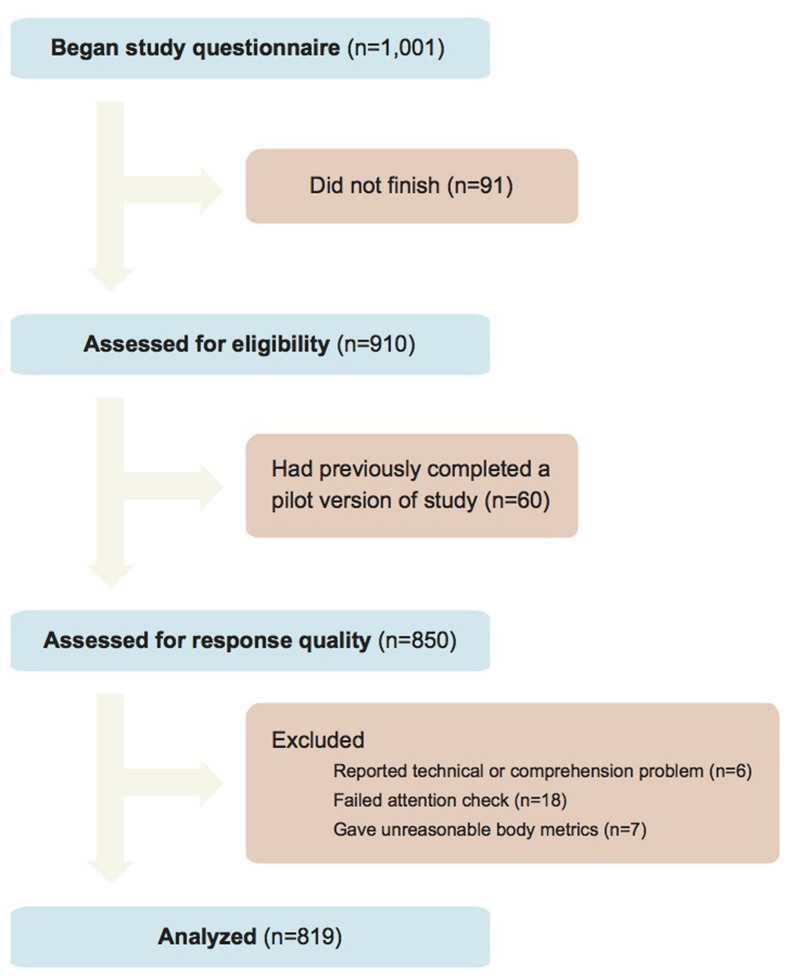
Study flow diagram.